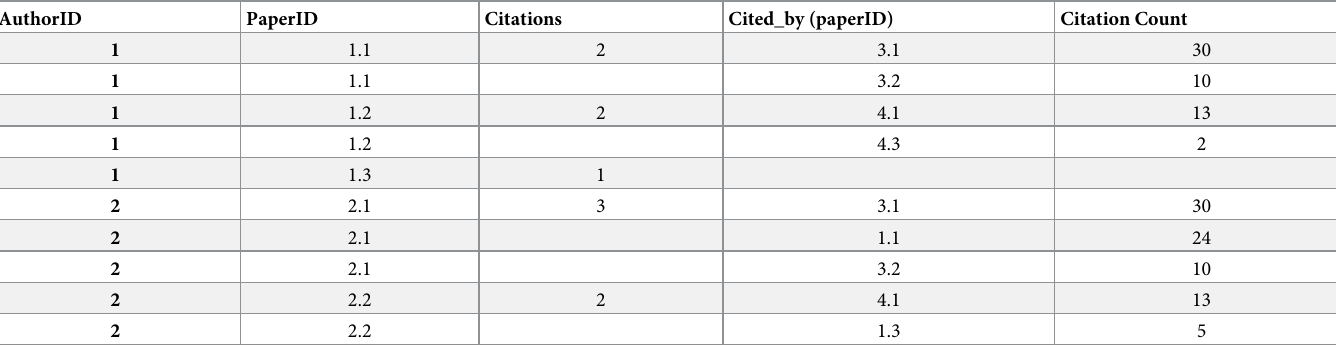
Table 5. Citation record of 2 authors from Table 2.